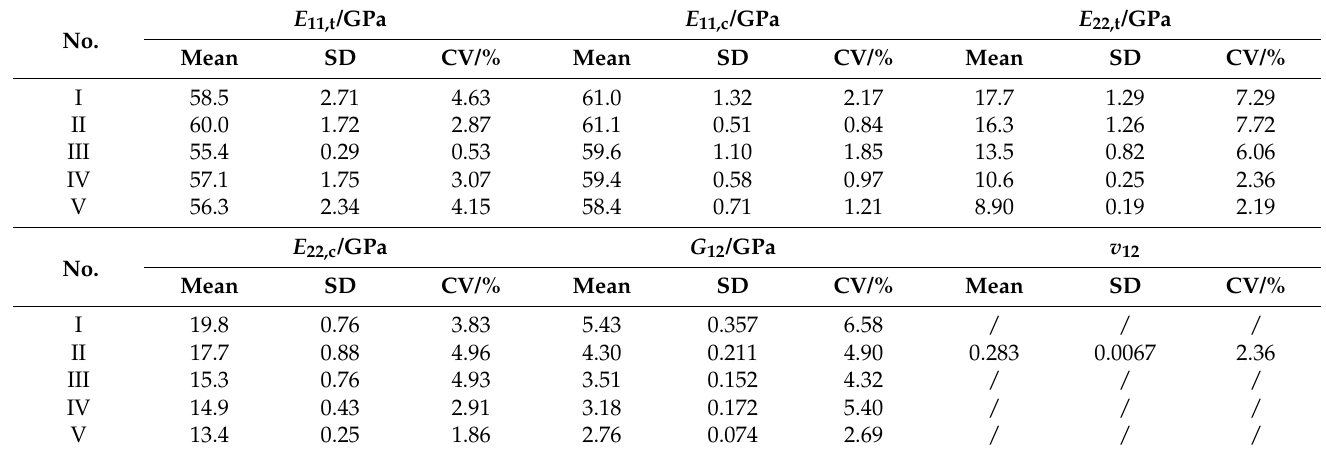
Table 4. Statistical values of stiffness properties of five batches of H-GFRP.